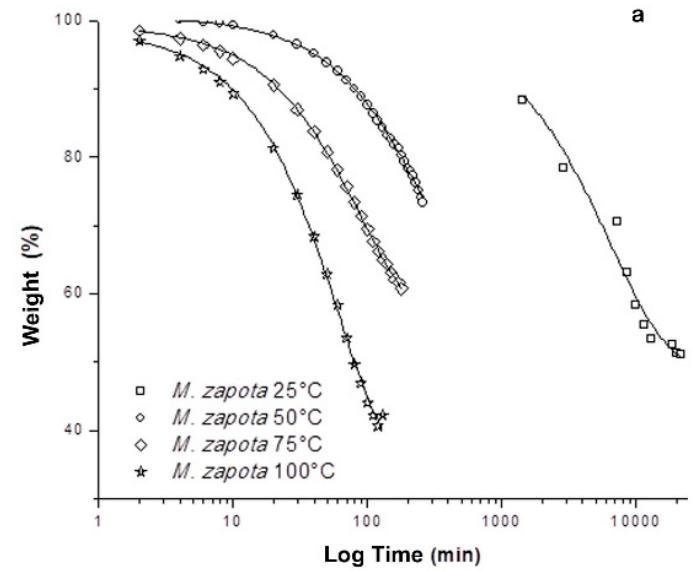
Figure 1. Drying process of M. zapota leaves at different temperatures (T = 25, 50, 75 and 100 °C).